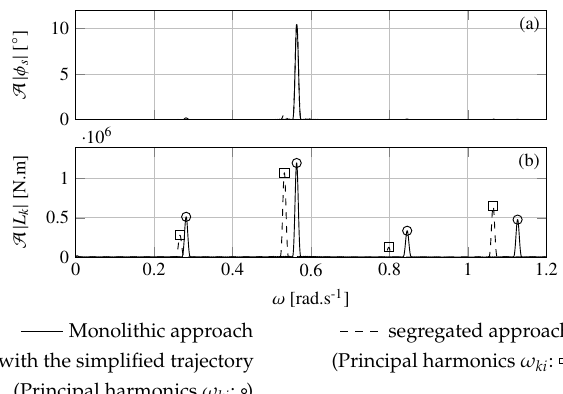
Figure 18. With a tether length L t = 470 m at the wave frequency ω w = 0.56 rad.s − 1 ; ( a ) Spectrum of the roll motion of the ship; ( b ) Spectrum of the kite excitation moment around the longitudinal ship axis x s